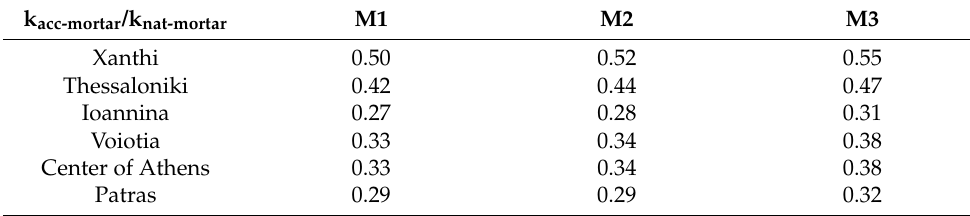
Table 21. Ratio k acc-mortar /k nat-mortar of cement mortars.